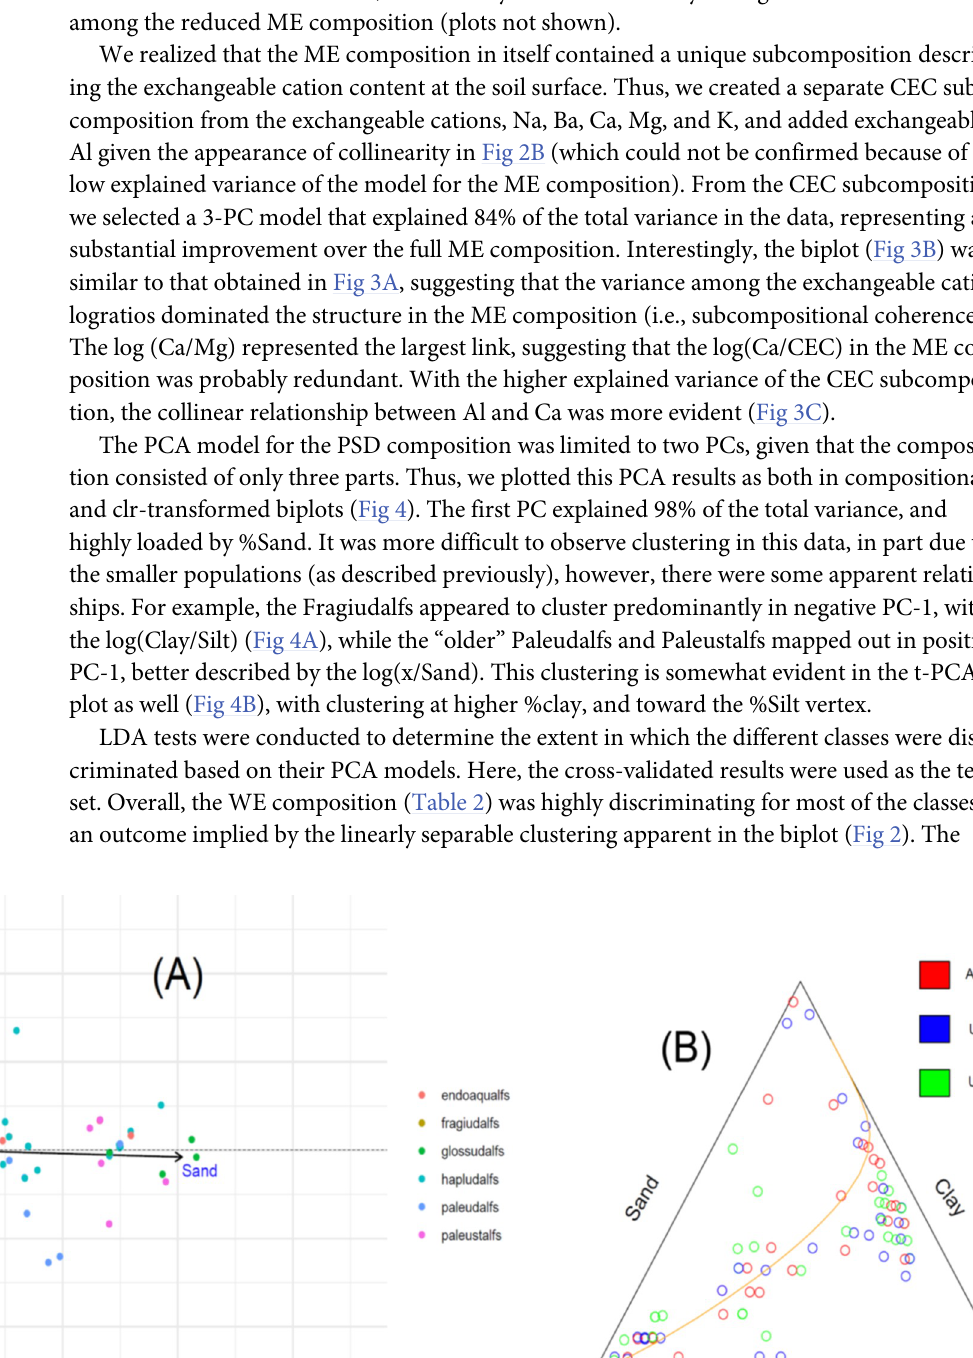
PLOS ONE | https://doi.org/10.1371/journal.pone.0212214 February 19,